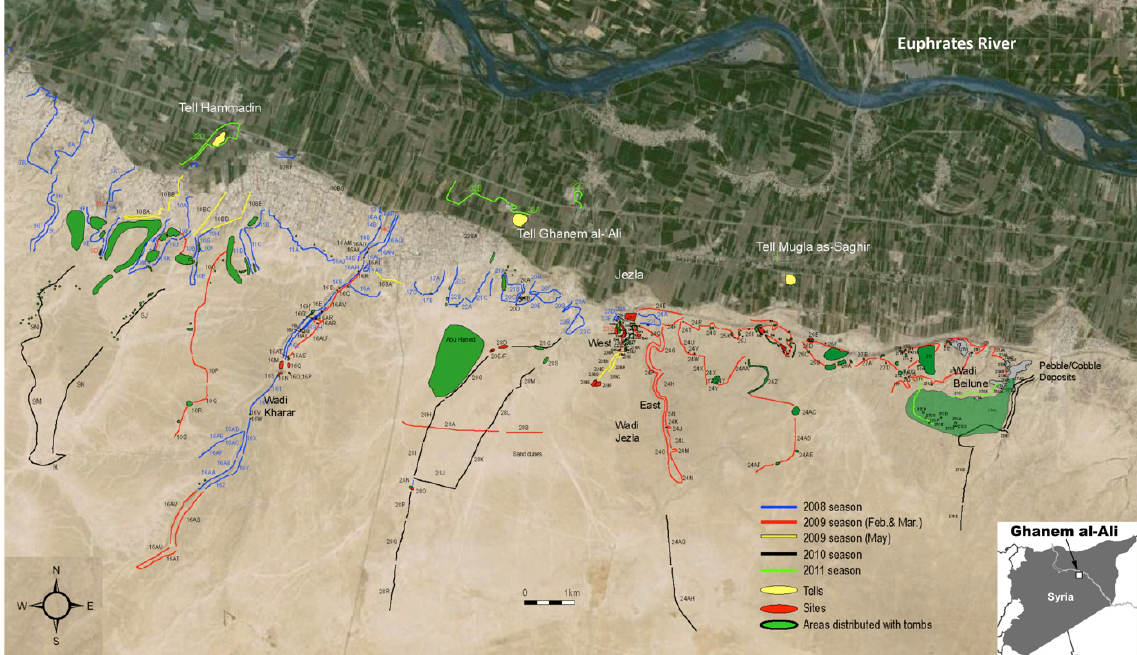
Figure 1. Map showing the location of Tell Ghanem al-Ali and the survey area. The numbers with letters indicate our survey